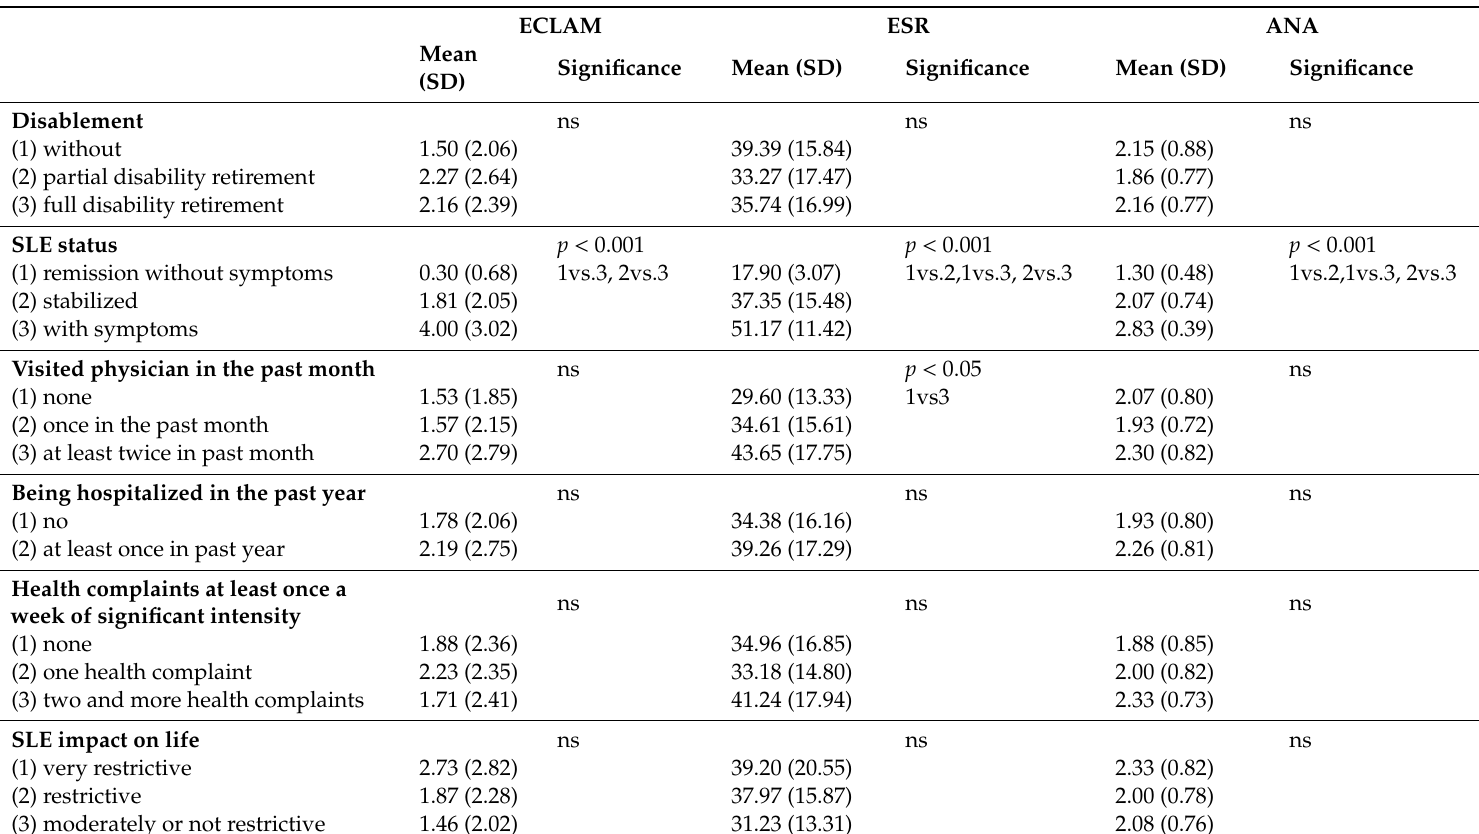
Table 6. The association of patients’ perspective with inflammatory markers ( t -test for two independent samples, one-way ANOVA, n =